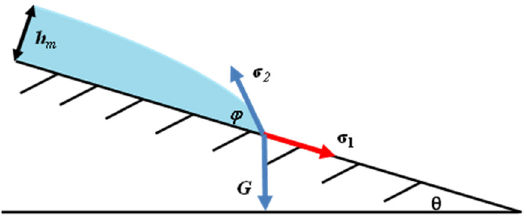
Figure 5. The force analysis when the fuel spreads on an inclined surface.